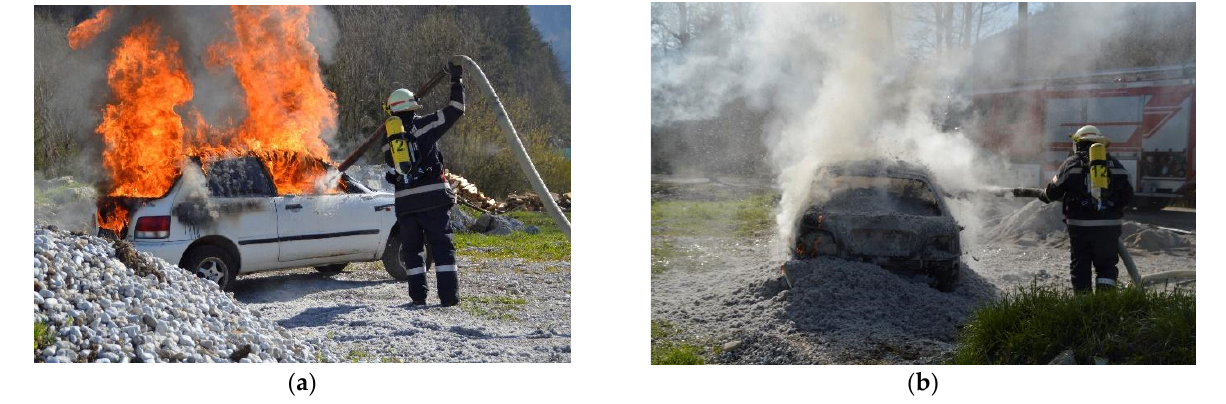
Figure 7. Trials with a magnesium fire (15 kg) inside a car. The cellulose flakes were able to control the flames. See text for